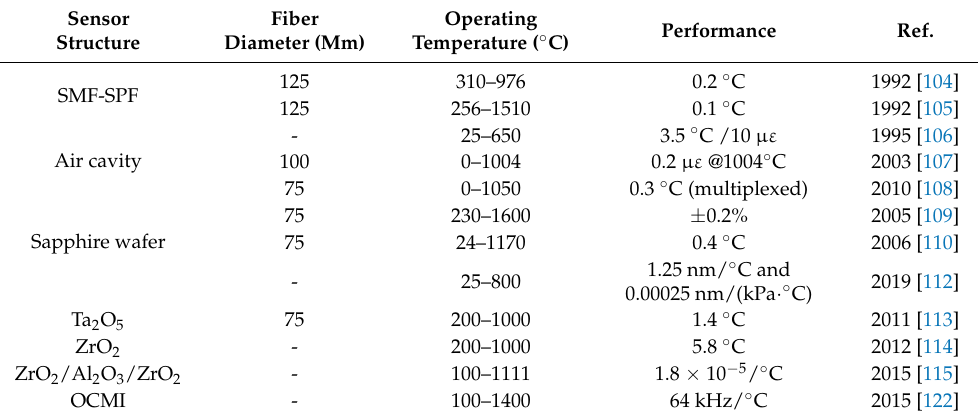
Table 4. Comparison of sapphire interference sensors.